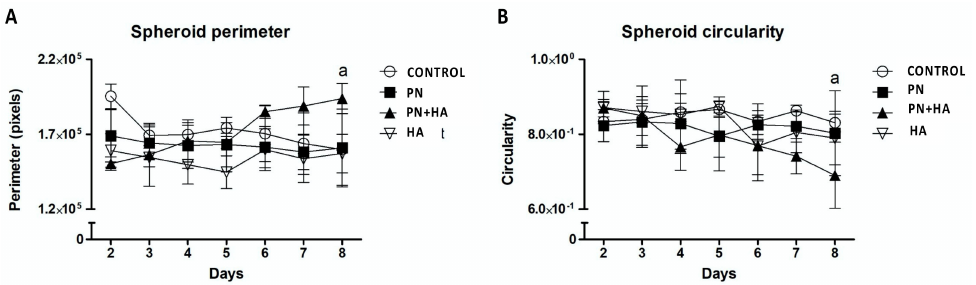
Figure 2. Changes in spheroid morphology as determined by ImageJ analysis. ( A ) Perimeter and ( B ) circularity of spheroids stimulated with vehicle (Control), Polynucleotides (PN) with or without Hyaluronic acid (PN + HA and HA respectively). a = p < 0.05 PN + HA vs. all